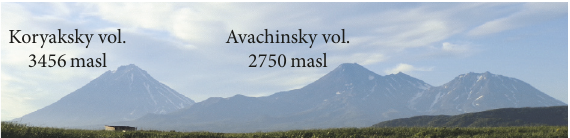
Figure 21: Koryaksky-Avachinsky volcanoes cluster, August 2016. Photo by D. Afanasiyev.